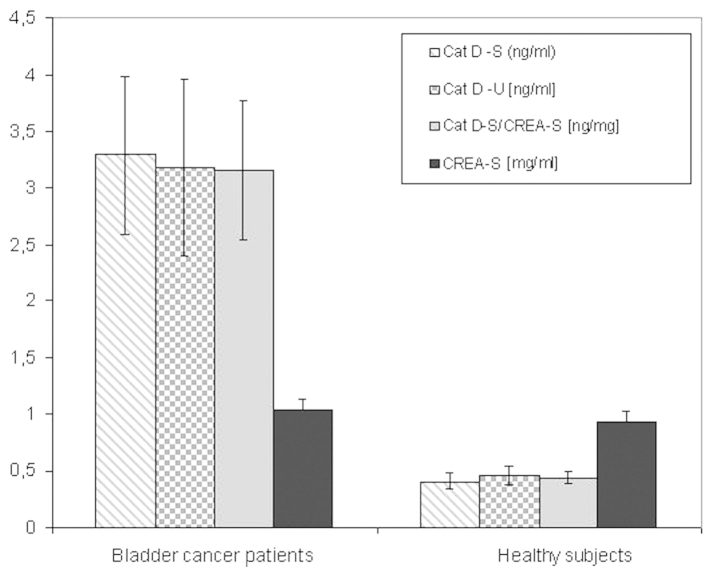
Concentration of Cat D in blood serum and urine, as well as concentration of CREA in blood serum, of bladder cancer patients and healthy subjects. The Cat D/CREA serum ratio is presented for comparison. Confidence bars were calculated at P=0.01. Cat D, cathepsin D; CREA, creatinine; S, serum; U, urine.